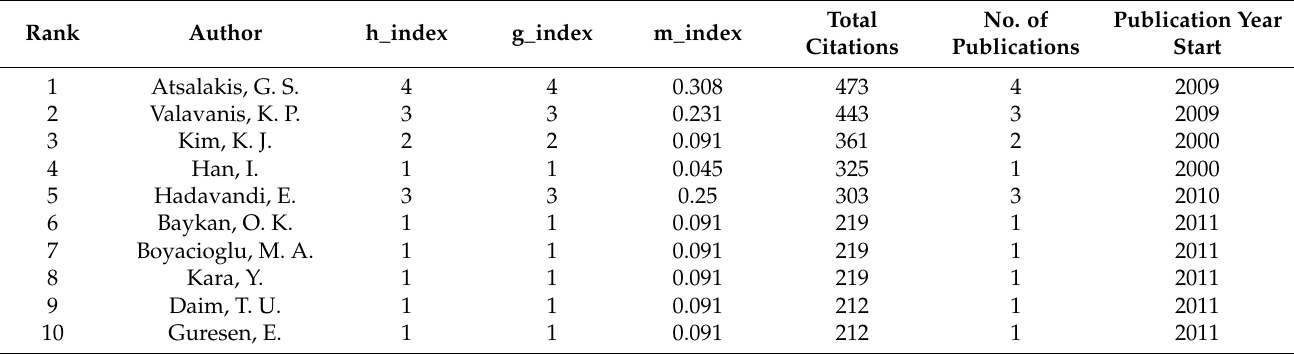
Table 3. Top 10 relevant authors.